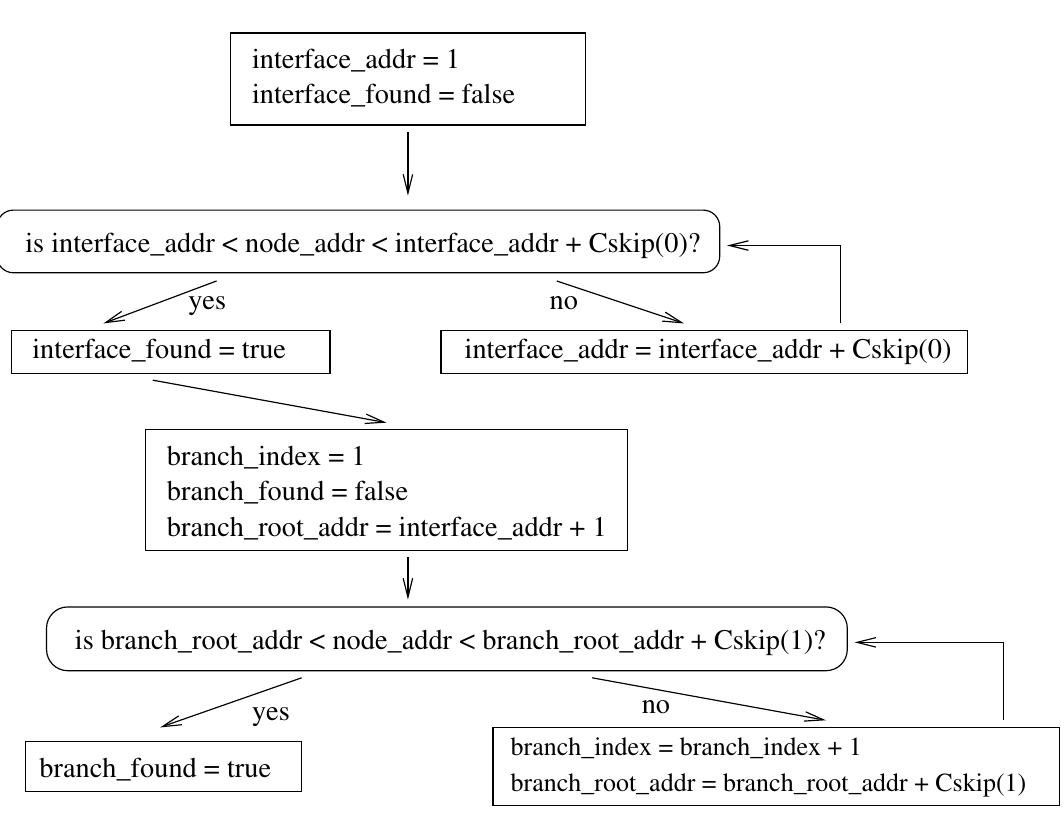
Figure 4. Algorithm for calculating the index of the branch to which a node is